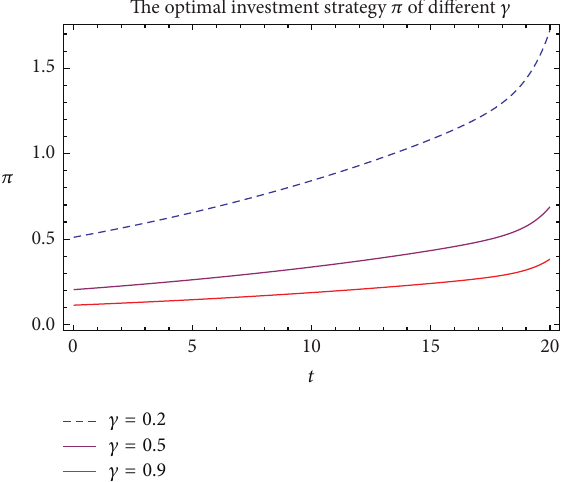
Figure 3: Evolutions of optimal investment strategy 𝜋 ∗ with different fund size 𝑥 for the same risk averse level.